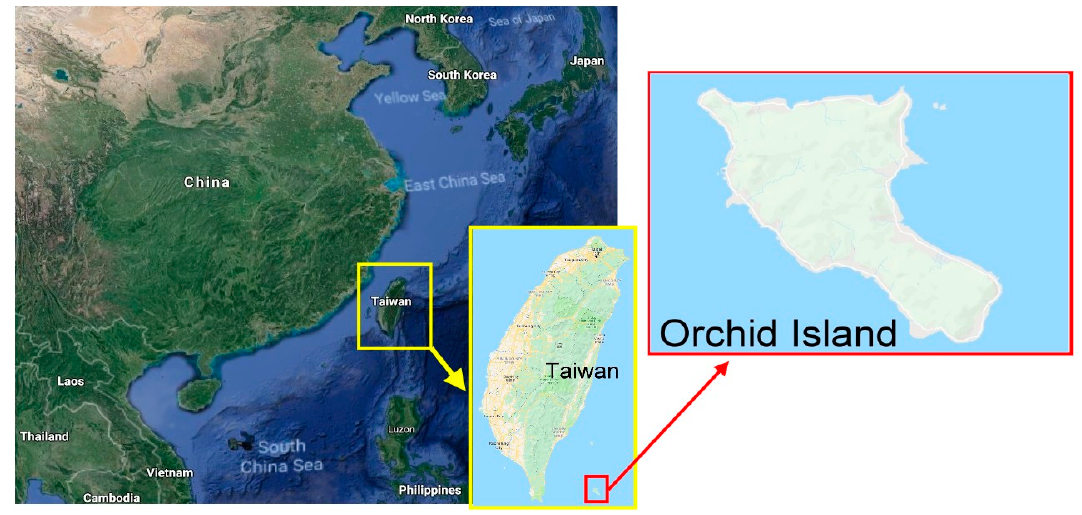
Figure 1. Map of the study area.